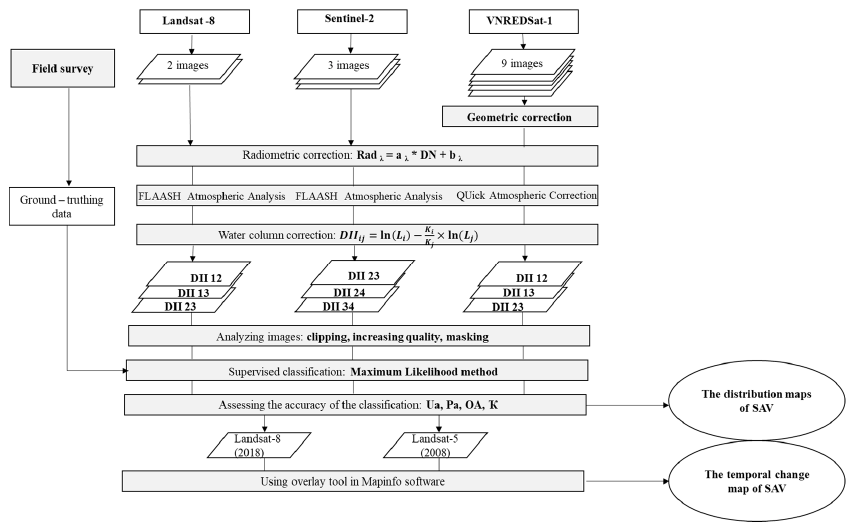
Figure 3. Process flow chart for establishing SAV distribution and temporal change mapping.